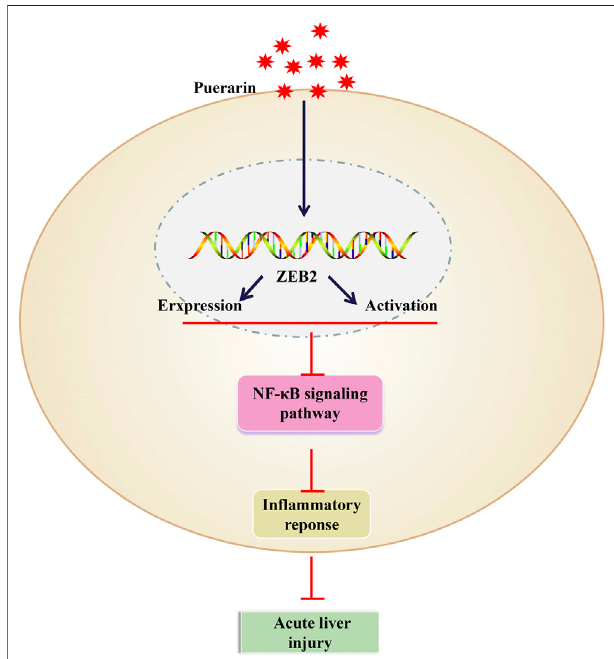
FIGURE 7 | Puerarin upregulated the expression levels of ZEB2 in a dose-dependent manner in LPS-induced L-02 cells. It was then able to inhibit the production of TNF- α , IL-6, and IL-1 β by suppressing the activation of the NF- κ B signaling pathway.